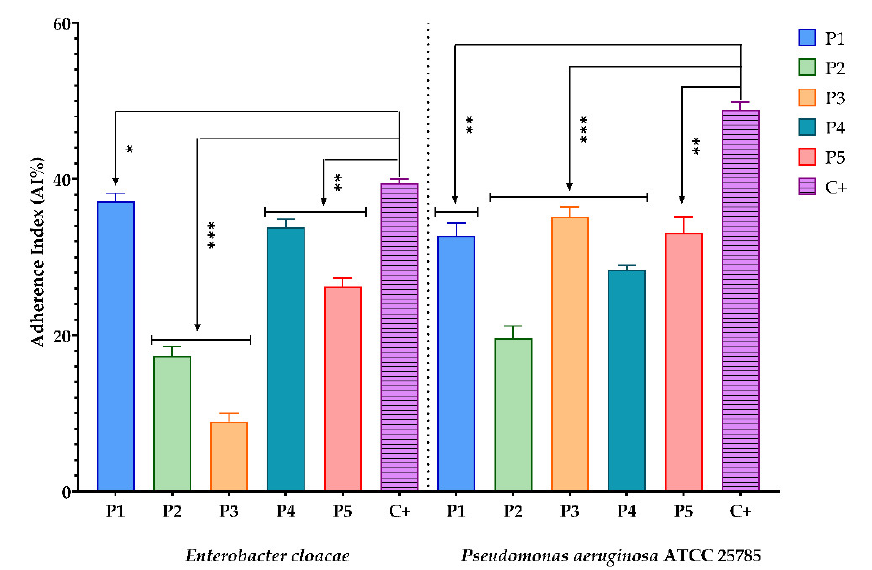
Figure 2. Graphic representation of AI% values representing the influence of BPE on the adherence capacity of Gram-negative bacteria; (P1–P5)-BPE samples; (C+)-bacterial adherence control. The significant impact of the BPE on the adherence capacity of E. cloacae and P. aeruginosa was tested by performing one-way ANOVA and Dunnett’s multiple comparisons tests. All data were considered statistically significant. (* p < 0.05; ** p < 0.01; *** p < 0.001).